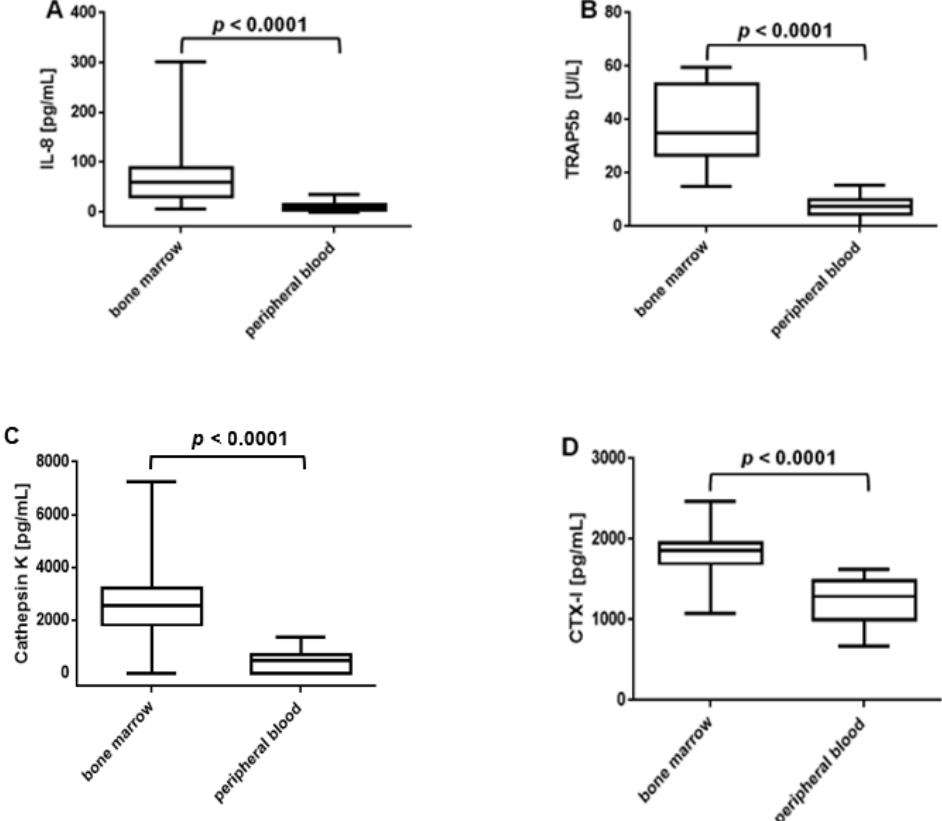
Figure 4. Concentrations of IL-8, TRAP5b, cathepsin K and CTX-I in paired bone marrow and peripheral blood samples of ACPA-positive RA patients. ( A – D ) Bone marrow/peripheral blood samples: n = 16 ( A ), n = 16 ( B ), n = 14 ( C ), n = 15 ( D ). Comparisons were performed using two-tailed Mann–Whitney U test ( A , C ) or two-tailed Student’s t -test ( B , D ). TRAP5b, tartrate-resistant acid phosphatase 5b; CTX-I, C-terminal telopeptide of type I collagen; ACPA, anti-citrullinated protein